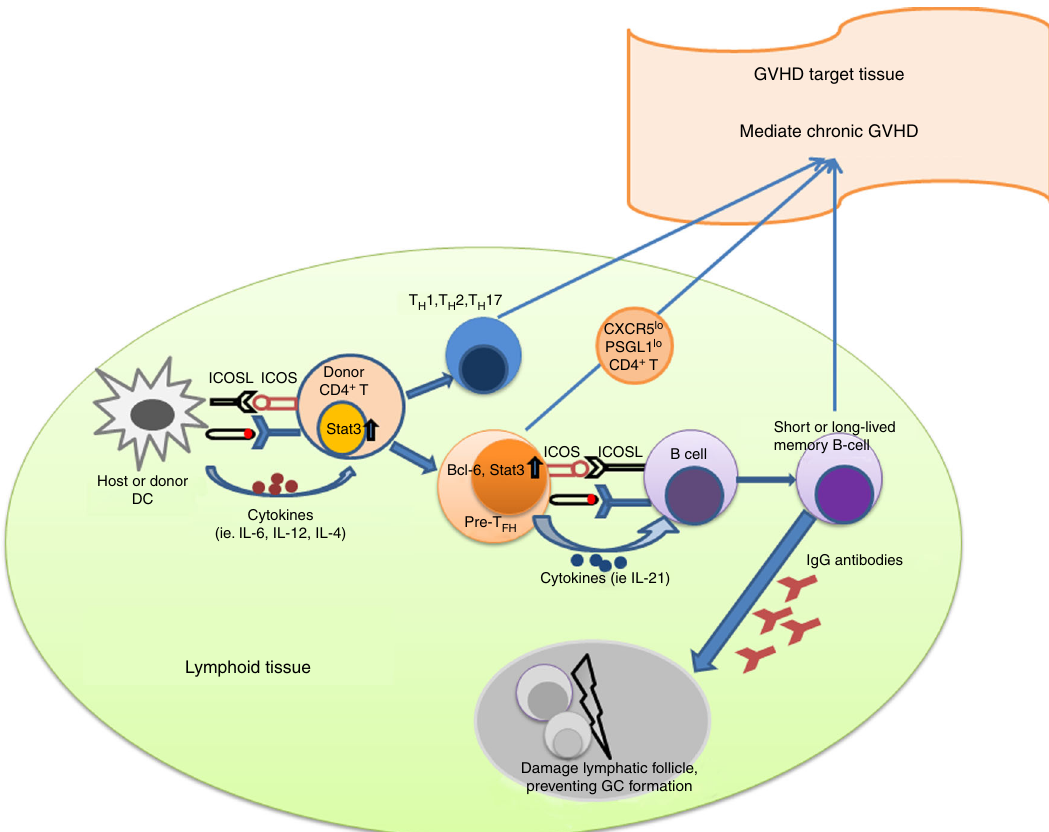
Fig. 9 Hypothesis on the potential function of PSGL-1 lo CD4 + T and B interactions in the pathogenesis of chronic